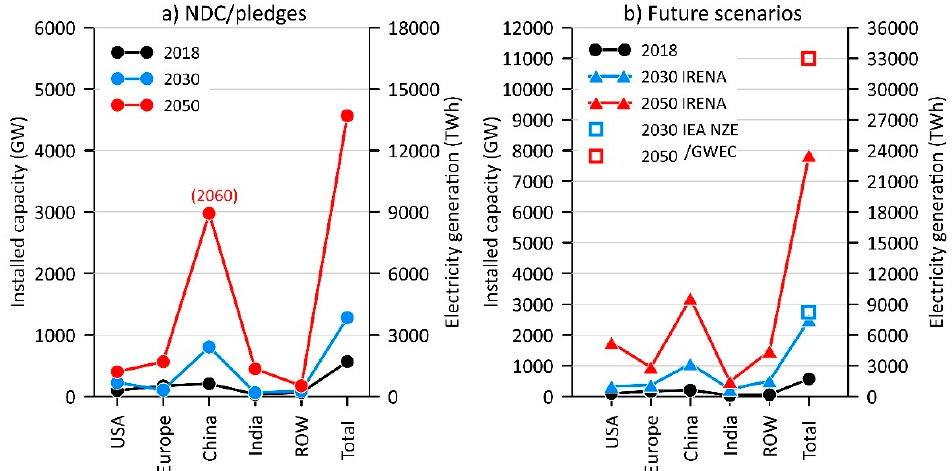
Figure 3. Wind energy installed capacity (IC) ( a ) Current IC (2018) and NDC/pledges/targets to 2030 and 2050 ( b ) Implied expansion of IC in different countries/regions under more ambitious wind energy scenarios. Values are estimated from IRENA [27] , IEA NZE [14] , GWEC [11] .